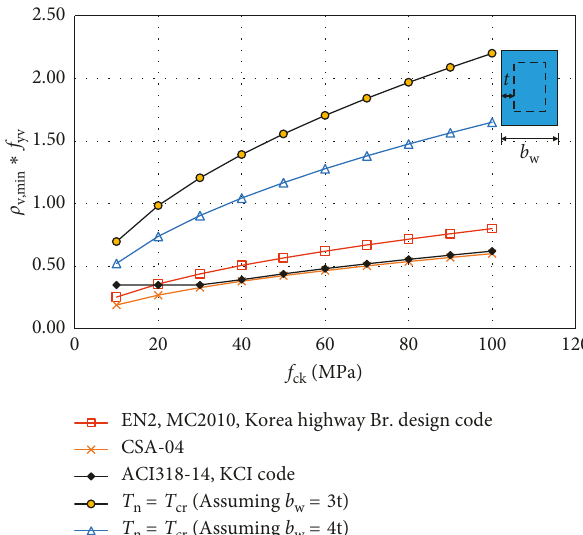
Figure 1: Minimum reinforcement ratio and torsional cracking